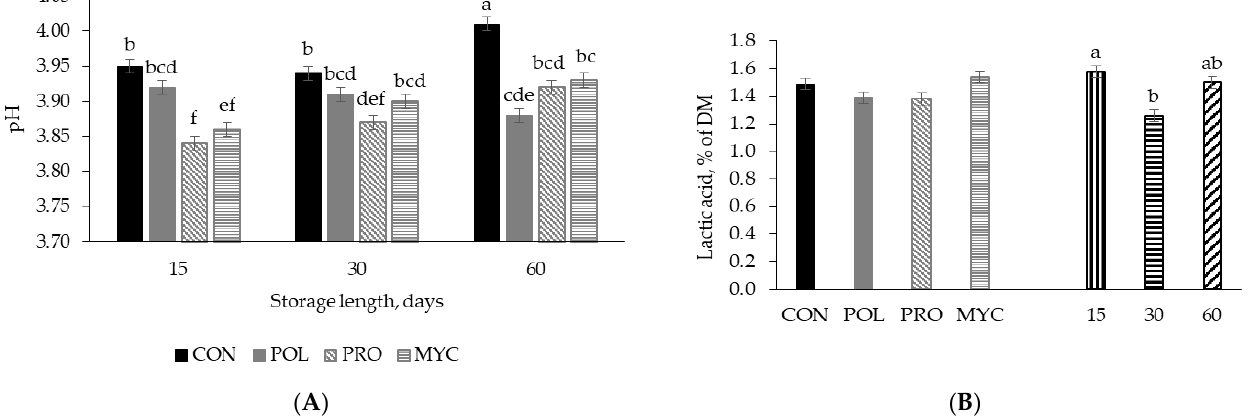
There was an interaction ( p < 0.01) between the additive and storage length for pH (Figure 2A). At d-30 of ensiling, only PRO had a lower ( p < 0.05) pH than CON, but after 60 d, all silages treated with additives had a lower ( p < 0.05) pH than CON. The lactic acid concentration was higher ( p < 0.05) at d-15 in comparison with d-30 of storage (Figure 2B).